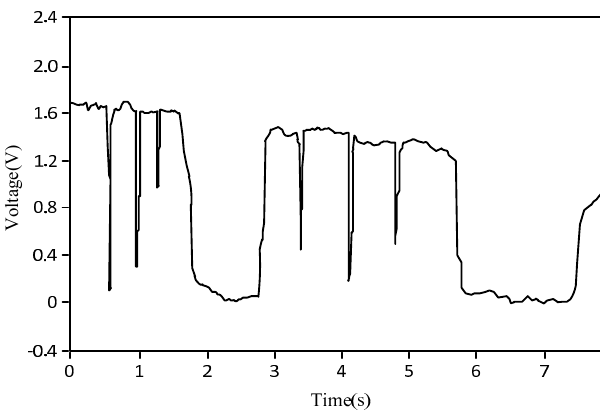
Sensors 2018 , 18 , x FOR PEER REVIEW